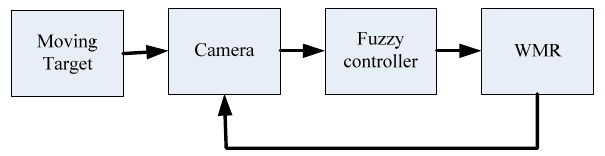
Figure 5. Dynamic tracking control scheme with fuzzy controller. Appl. Sci. 2016, 6, 82